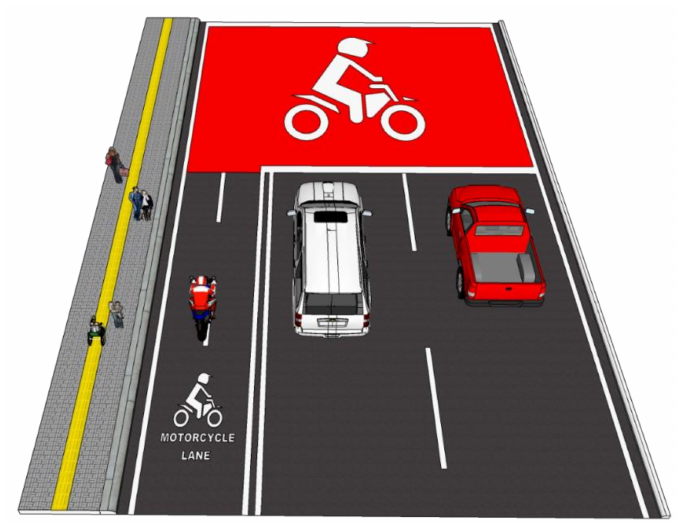
Figure 2. Red box for motorcycles that has motorcycle lane as an